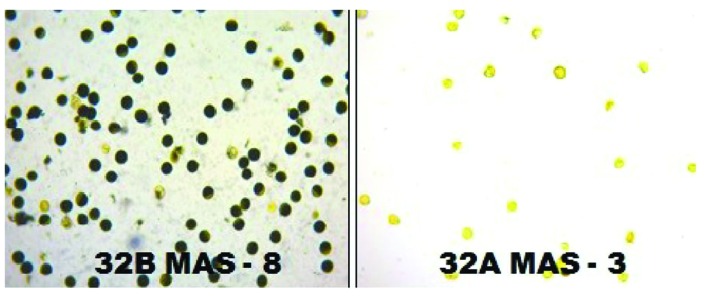
The fertility and sterility status of the pollen grains in improved lines of CRMS 32B MAS-8 and CRMS 32AMAS-3 (I2-KI staining).